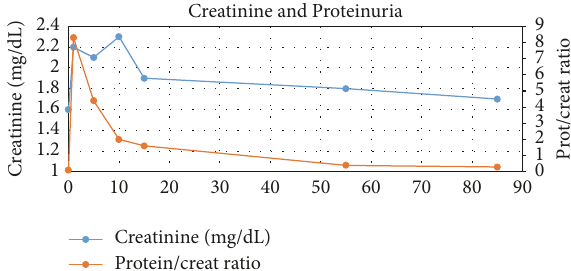
Figure 3: Creatinine and spot urine protein/creatinine ratio during clinical